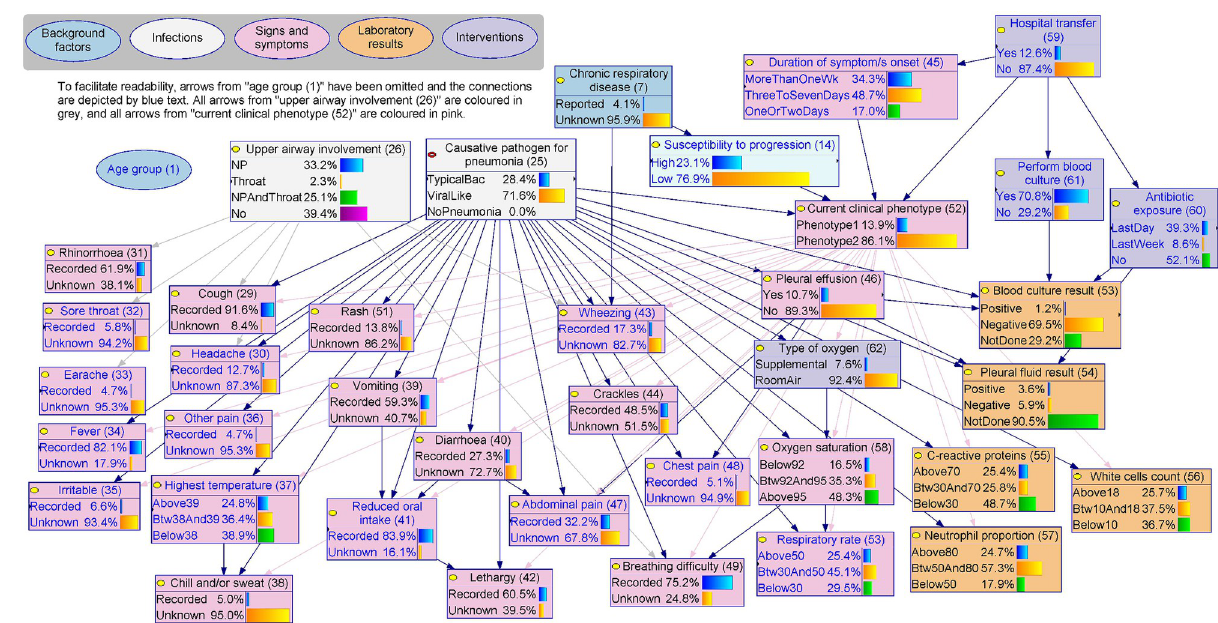
Fig 6. The evidence, BN v4.5. Causative pathogen for pneumonia, current clinical phenotype and upper airway involvement interact to give rise to the various types of evidence including clinical signs, symptoms, and laboratory results. The BN dictionary (S1 Table) details how these latent variables may give rise to each type of evidence. Source model files can be accessed via Open Science Framework